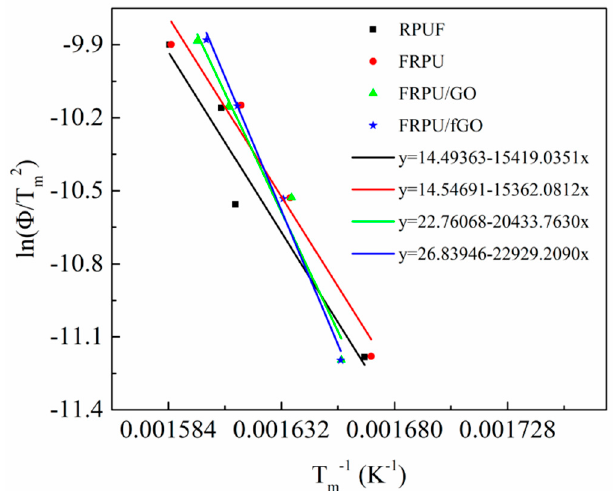
Figure 3. Kissinger method applied to the experimental TG data of RPUF specimens at different heating rates under a nitrogen atmosphere.